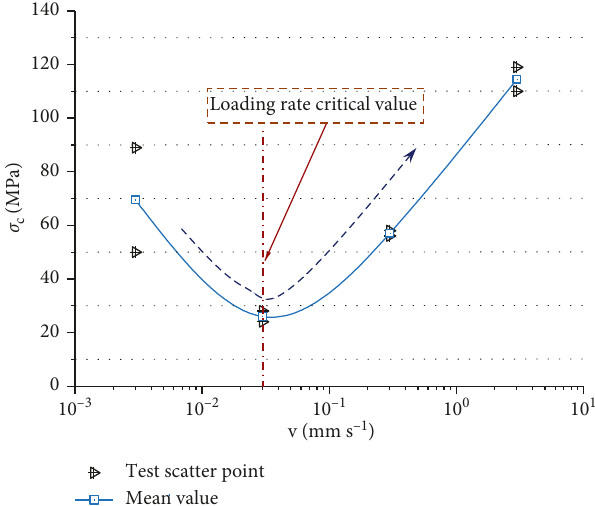
Figure 6: Change curves of mudstone peak strength with loading rates